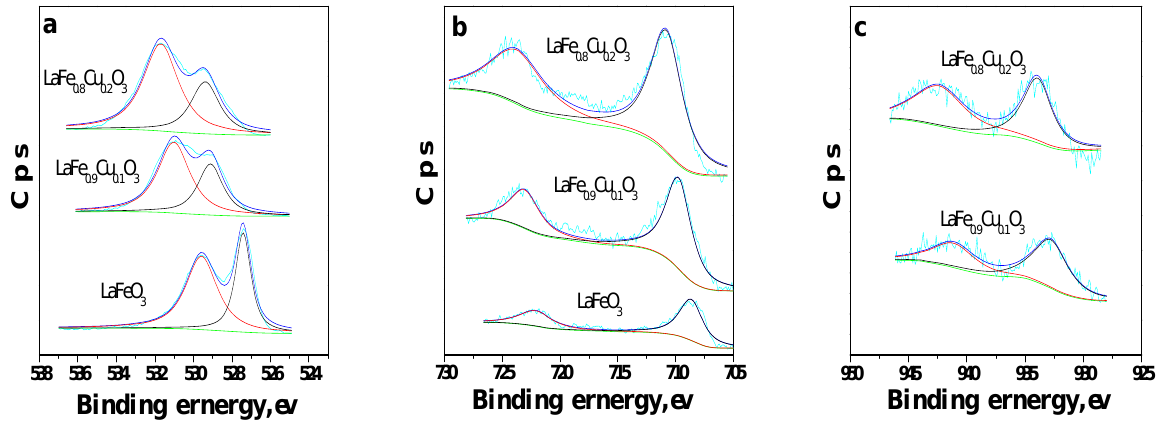
Cu O (x=0, 0.1, 0.2) (a. O 1s; b. Fe 2p; c. Cu 2p). 1-x x 3